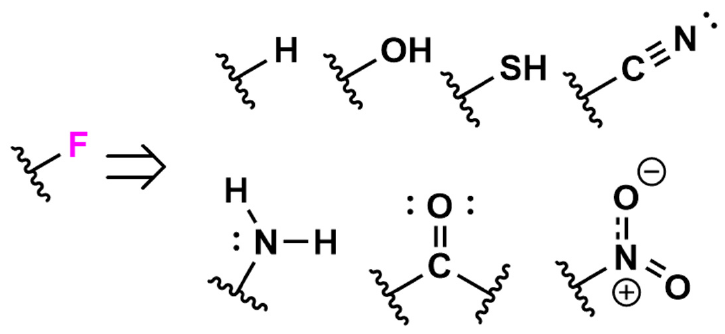
Figure 4. Fluorine as a versatile bioisostere accompanied by the functional groups it has been reported to mimic.